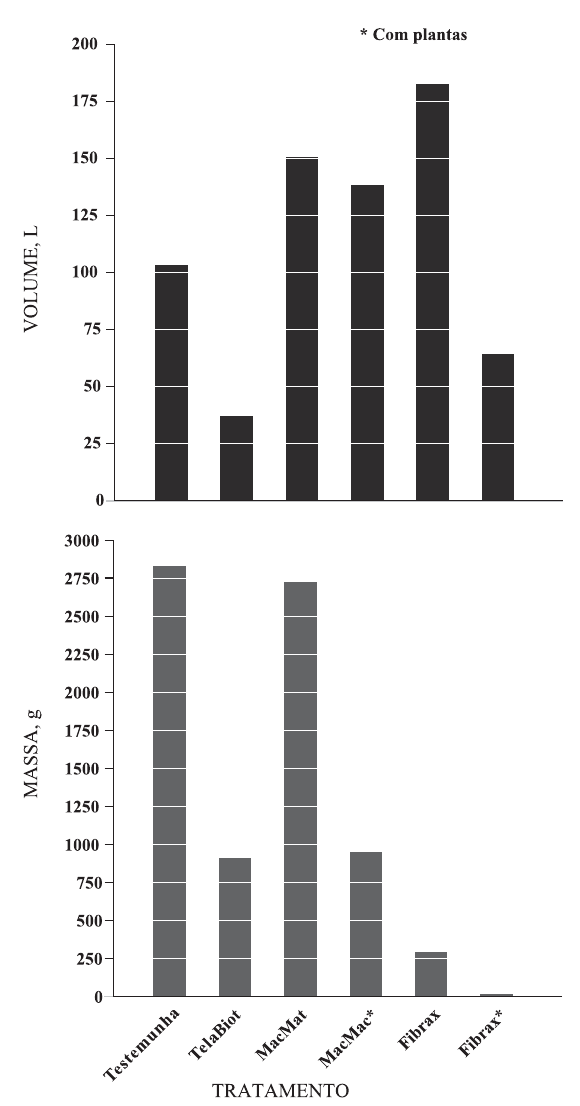
Figura 3. Totais de volume acumulado de suspensão água + solo escoado e massa de solo perdida por